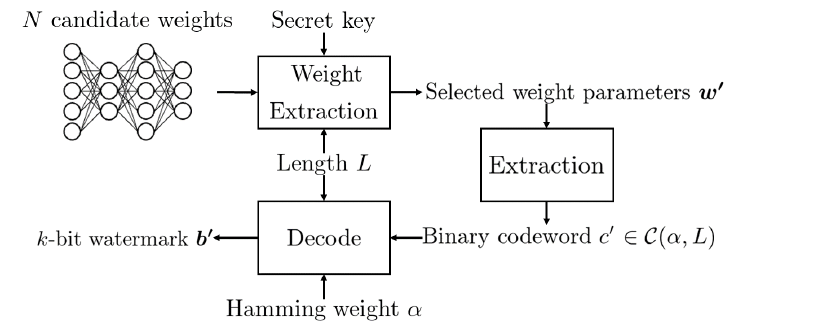
Figure 2. Flow diagram of extraction